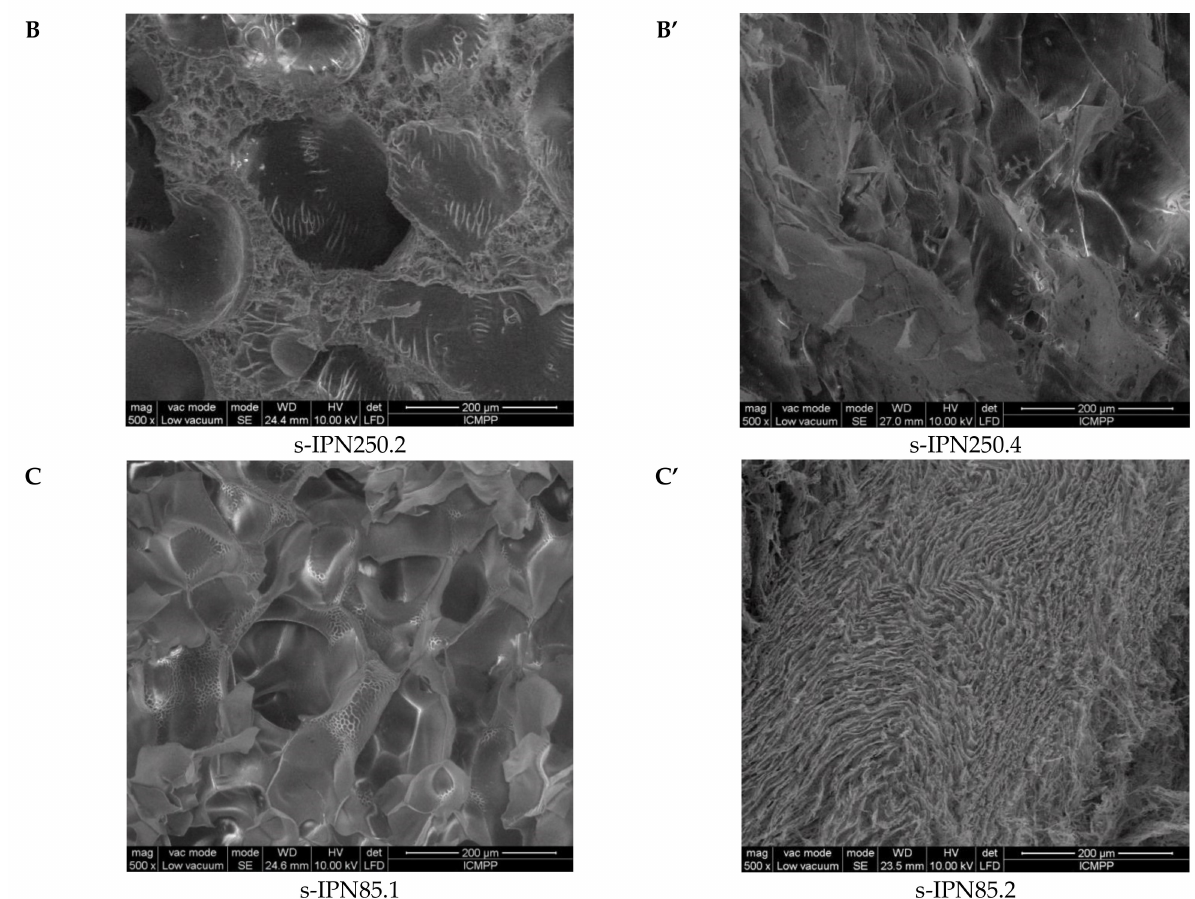
Figure 3. Cross-sectional SEM micrographs of the semi-IPNs with PDMAEMA250 (images A , A’ , B , and B’ ) and PDMAEMA85 (images C and C’ ), at a cross-linking ratio of PAAm of 1:80 (images A , B , C ) and of 1:40 (images A’ , B’ , C’ ). (The composition of the samples can be found in Table 2 following the sample